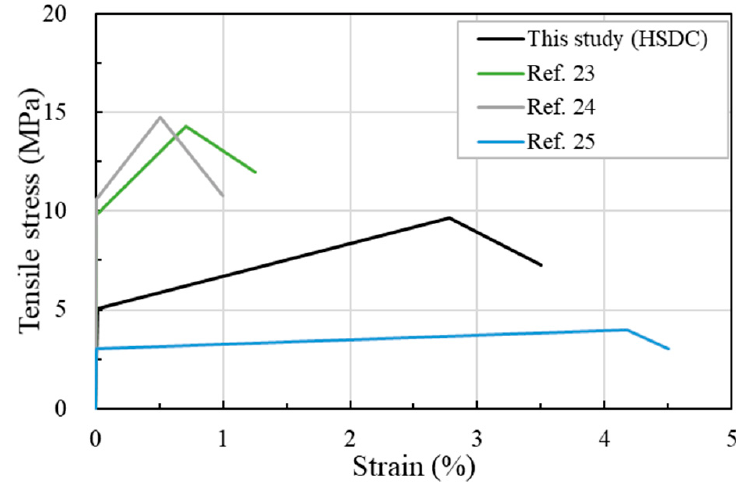
Figure 10. Comparison of tensile stress and strain. The corresponding damage level was then evaluated according to the design criteria provided by UFC-3-340-02. The protective design manual defines the base of support rotation at three levels, light damage (0 ◦ ≤ θ < 2 ◦ ), moderate damage (2 ◦ ≤ θ < 5 ◦ ), and severe damage (5 ◦ ≤ θ < 12 ◦ ).